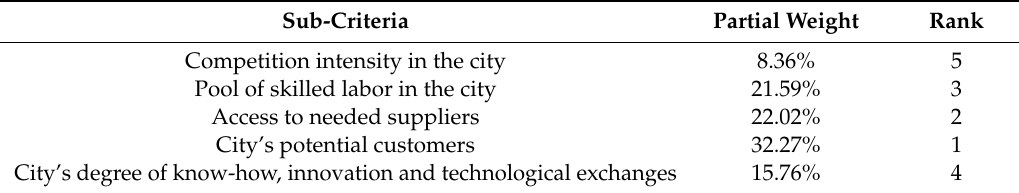
Table 12. Sub-criteria relative weight and rank of Market conditions for energy firms in the